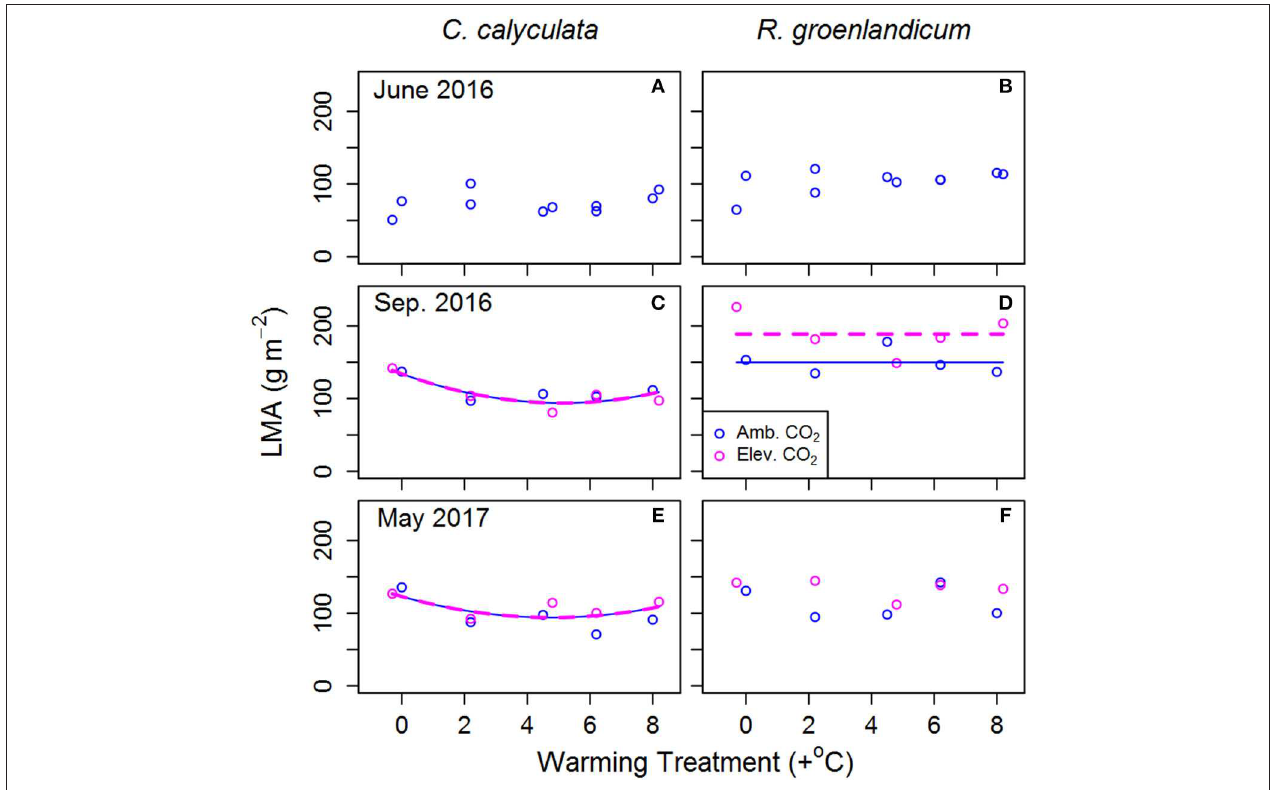
FIGURE 4 | Mean leaf mass per unit projected leaf area ( LMA ) for two shrub species at the SPRUCE site in each plot, for newly expanded ( A,B ; June 2016), mature ( C,D ; September 2016), and overwintered ( E,F ; May 2017) leaves. Lines indicate fit of best model, as evaluated using Akaike Information Criterion corrected for sample size (AICc). Panels without lines have intercept-only best models as shown in Table 2